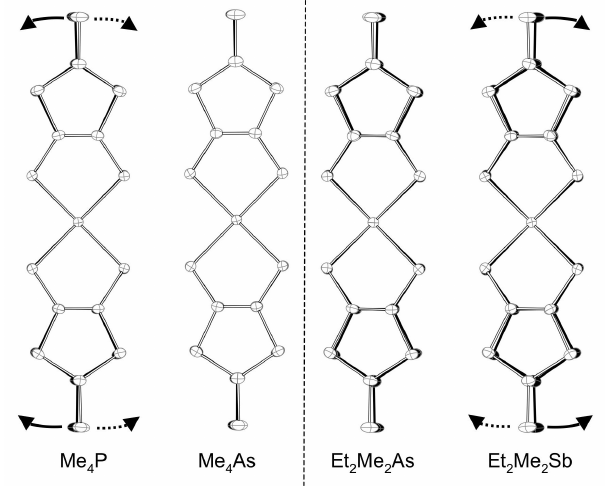
Figure 8. [Pd(dmit) ] 2− dimers viewed along the vector connecting the two Pd atoms in 2 Me P, Me As, Et Me As, and Et 4 4 2 2